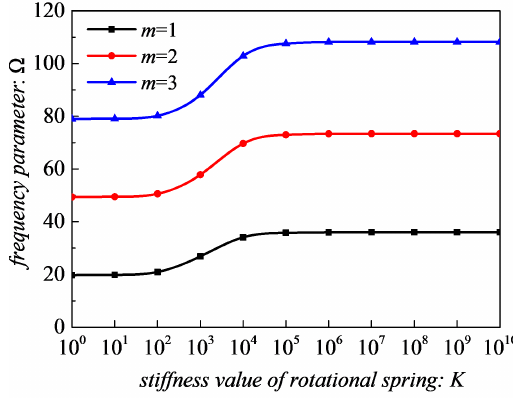
Figure 2: Realtionship between Non-dimensional frequency